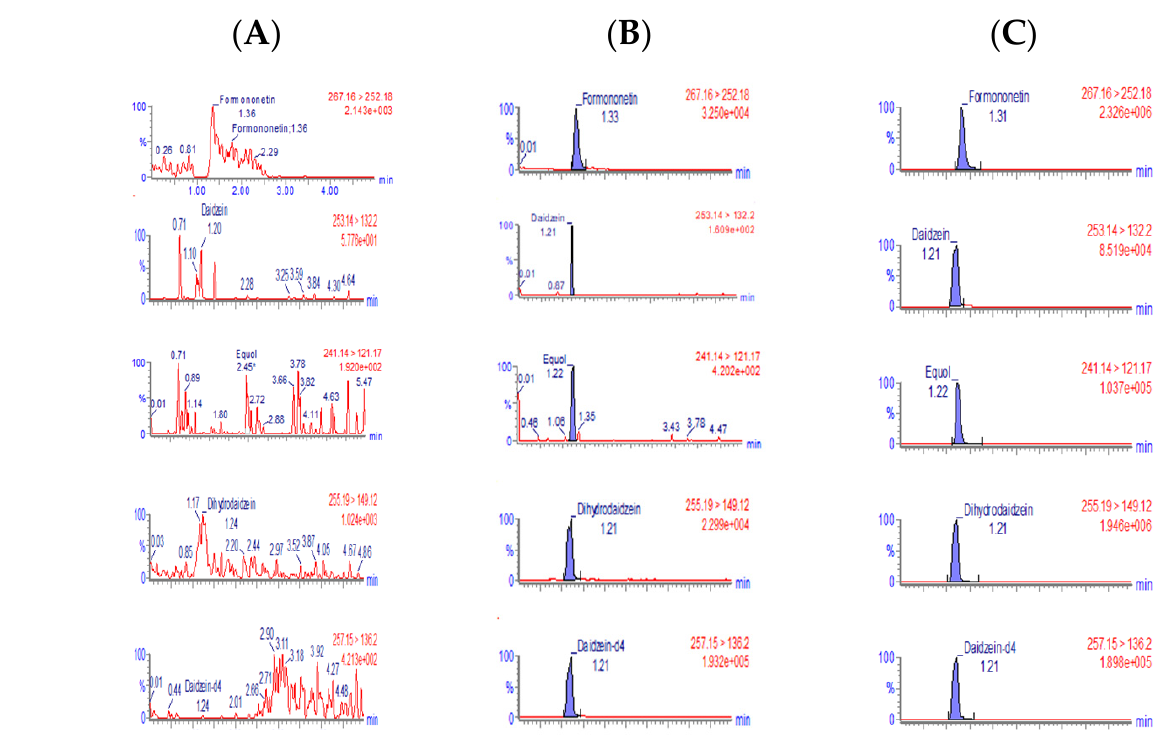
Figure 3. Representative multiple reaction monitoring chromatogram of ( A ) blank plasma sample ( B ) blank plasma spiked with target analytes and IS at LLOQ concentration and ( C ) blank plasma spiked with target analytes and IS at ULOQ concentration.